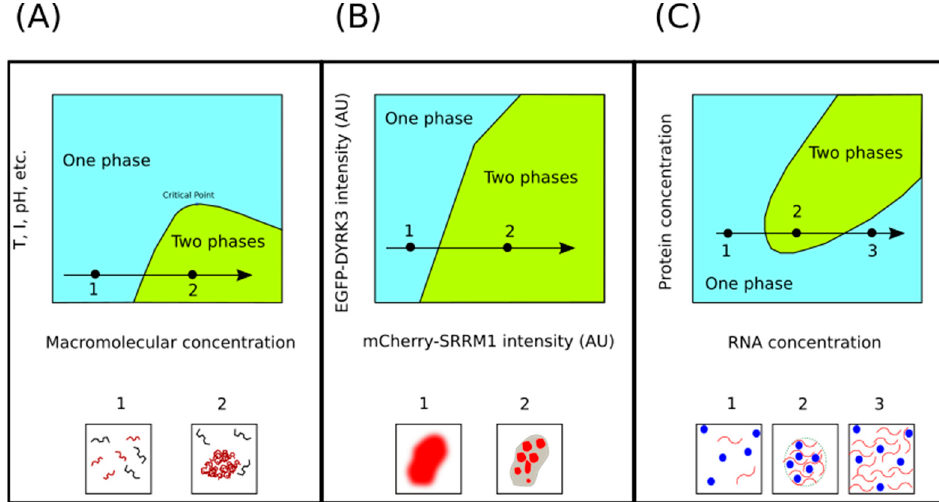
Figure 2. Schematic phase diagrams; ( A ) The black curve separating the plane into two regions (one- phase in cyan and two-phase in green) informs about the conditions (macromolecular concentration; temperature, T; ionic strength, I; pH; etc.) at which the two regimes coexist in equilibrium. At a given value of the environmental variable, an increase in the concentration (black arrow) of the scaffold macromolecule leads from the one-phase to the two-phase state (squares 1 and 2, respectively, where the scaffold macromolecules have been represented in red). ( B ) Schematic representation of the results reported in [55]. In a population of cells expressing the fluorescent tagged proteins EGFP-DYRK3 (a kinase with dissolvase activity) and mCherry-SSRM1 (a nuclear substrate of the DYRK3 kinase), nuclear intensities of both signals can be recorded and plotted in a Cartesian plane using arbitrary units (AU). The black line splitting the plane in two regions is given by the ki- nase/substrate ratio above which the nuclear condensates containing SSRM1 melt. Thus, at a fixed value of kinase concentration, moving from lower to higher concentrations of the kinase substrate (black arrow) leads to the assembly of condensates (square 1 and 2, respectively). ( C ) Phase diagram of RNA-protein mixtures. The black arrow represents, at a given protein concentration, the direction in increasing RNA concentrations. An initial increase in RNA concentration drives phase transition from one phase (square 1) at low RNA levels to two phases (square 2) at intermediate levels of RNA. Further increasing the RNA concentration drives the second phase transition, now from two phases (square 2) to one phase (square 3) after dissolution of the condensates. This process, known as RNA- mediated reentrant phase transition, is thought to be driven by electrostatic forces.